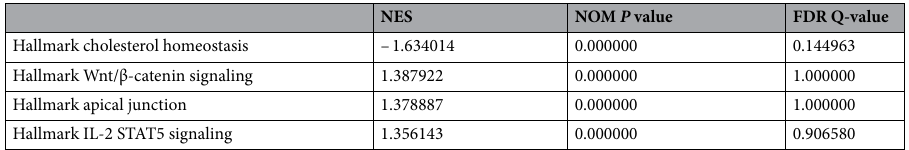
Table 2. Summary of results of GSEA. GSEA was conducted using the open source software GSEA 3.0. Summary of results of GSEA showing a P value < 0.00001 or Q -value < 0.25. FDR, false discovery rate; GSEA, gene set enrichment analysis; IL, interleukin; NES, normalized enrichment score; NOM, nominal.